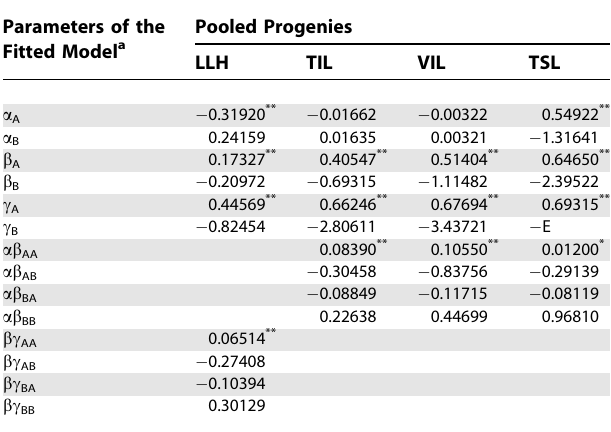
Table 2. Analysis of Frequency Distribution of Genetic Types in Pooled Progenies from Double Inoculations of IA and IB CMV Isolates and Fitting of Log-Linear